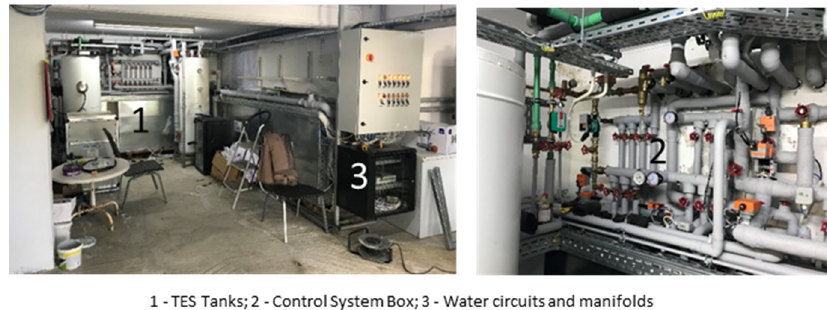
Figure 7. View of the engine room.